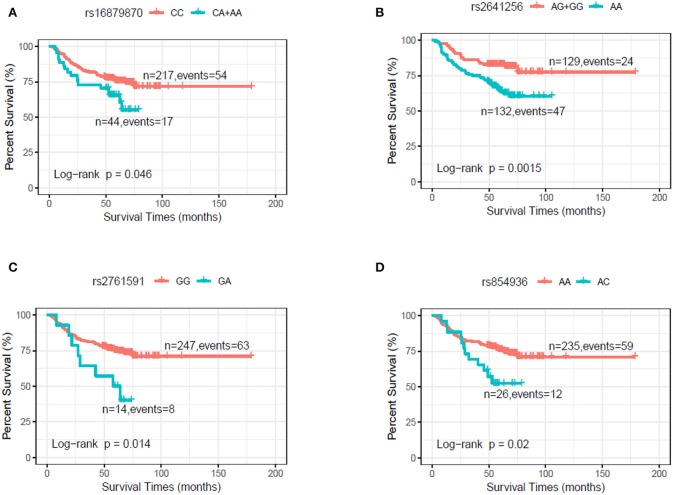
Kaplan–Meier plot by genotypes of selected SNPs in dominant model in the discovery stage. (A) rs16879870 (CC vs. CA+AA). (B) rs2641256 (AG+GG vs. AA). (C) rs2761591 (GG vs. GA). (D) rs854936 (AA vs. AC).